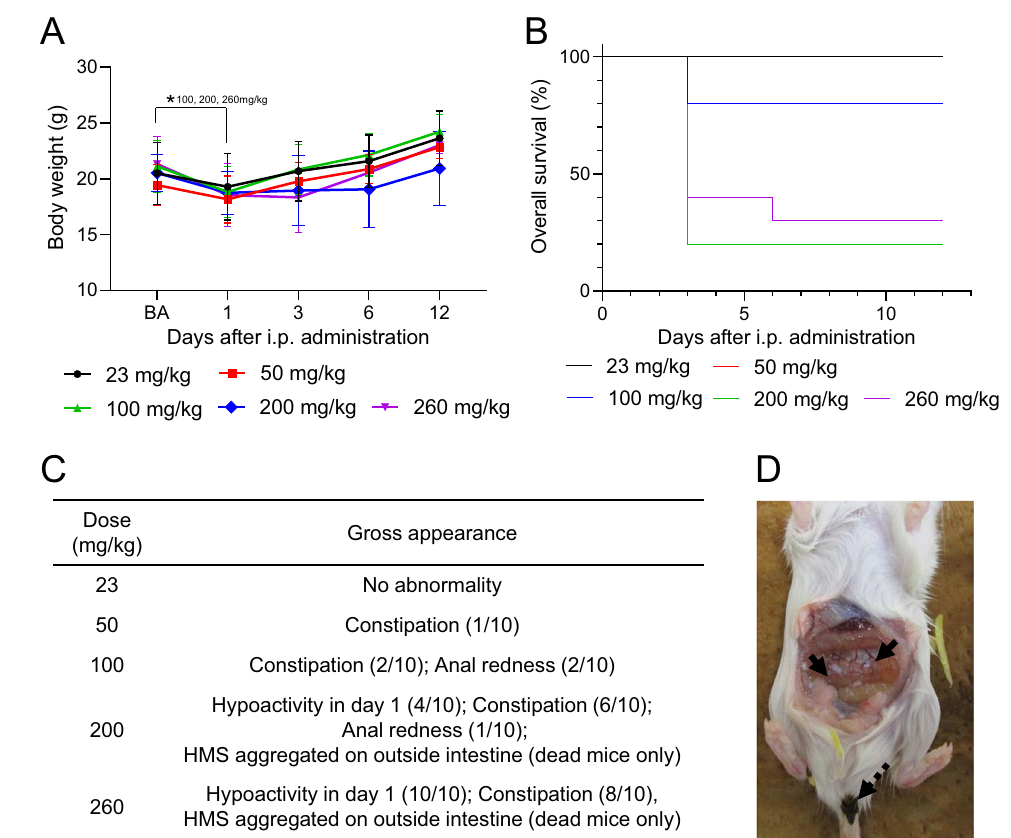
Fig. 3 Observation results of the mice after intraperitoneal adminis- tration with HMS particles. A Body weight changes. * p < 0.05 Stu- dent ’ s t test (vs. BA). B Overall survival. The survival curves for the 23 and 50 mg/kg administration groups were overlaid because no mice were dead in both, and because the rates of overall survival maintained